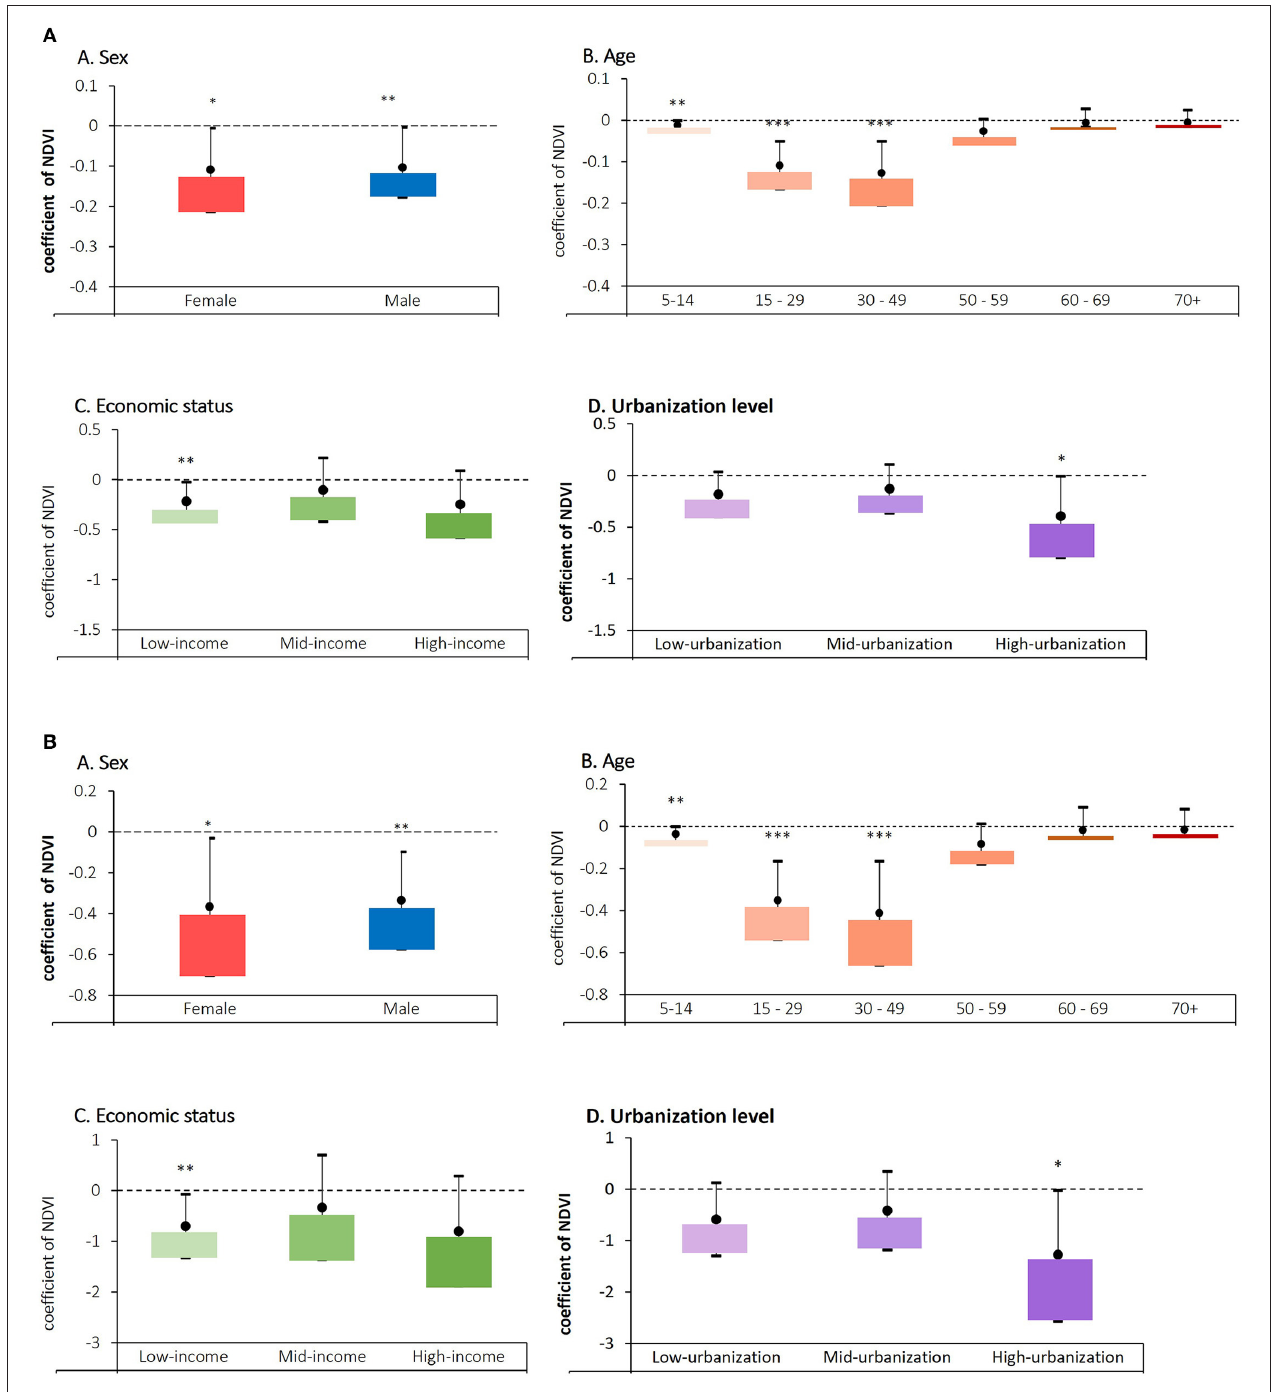
FIGURE 3 | Stratified analysis by sex, age groups, economic status, and urbanization levels in relation to depressive disorders in the DALY changes based on (A) crude NDVI; increase in NDVI from 0 to 1, (B) interquartile increment unit of NDVI (IQR = 0.309).